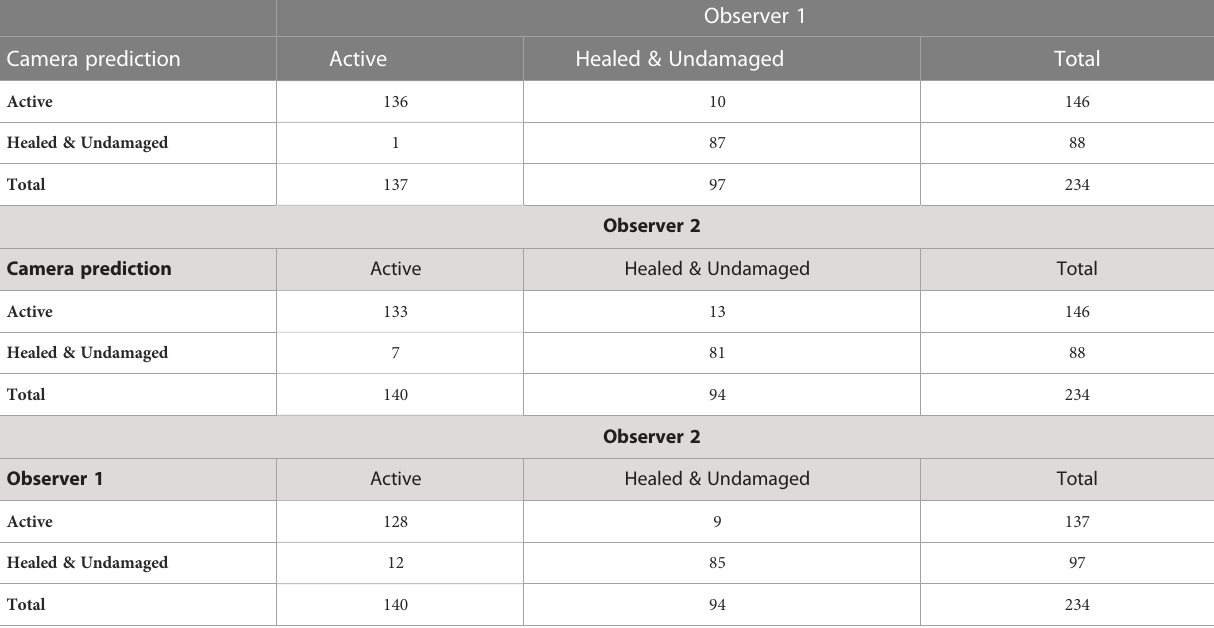
TABLE 3 Confusion matrices for distinguishing active injuries from healed or undamaged dorsal fi ns between dorsal fi n haemorrhaging index and human observers, as well as between human